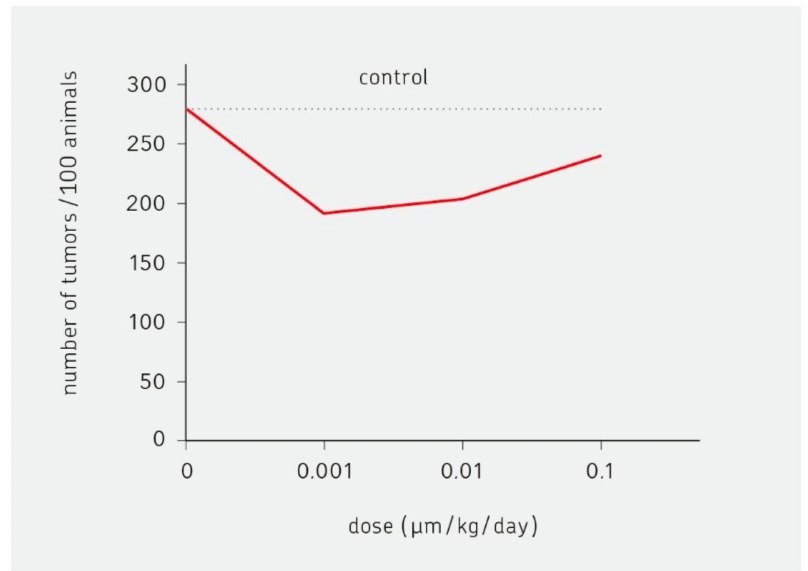
Figure 1. Example of a hormesis effect. The effect of dioxin on the development of breast cancer in rats. In a low dose (0.001 mm/kg/day) the incidence of tumors is strongly reduced. According to Kaiser, J.